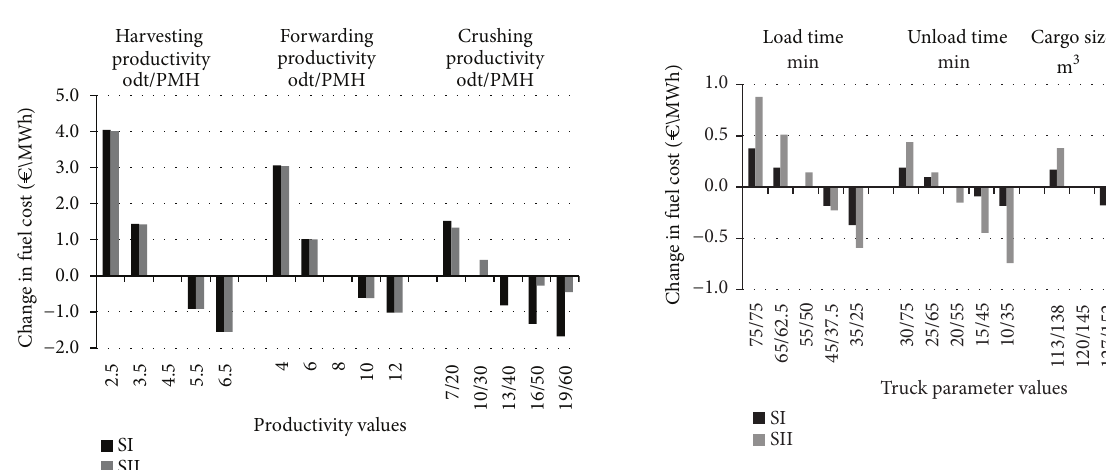
Figure 7: Influence on fuel cost (C/MWh) of changes in truck- related properties. When two values are given, the first is for system SI and the second for system